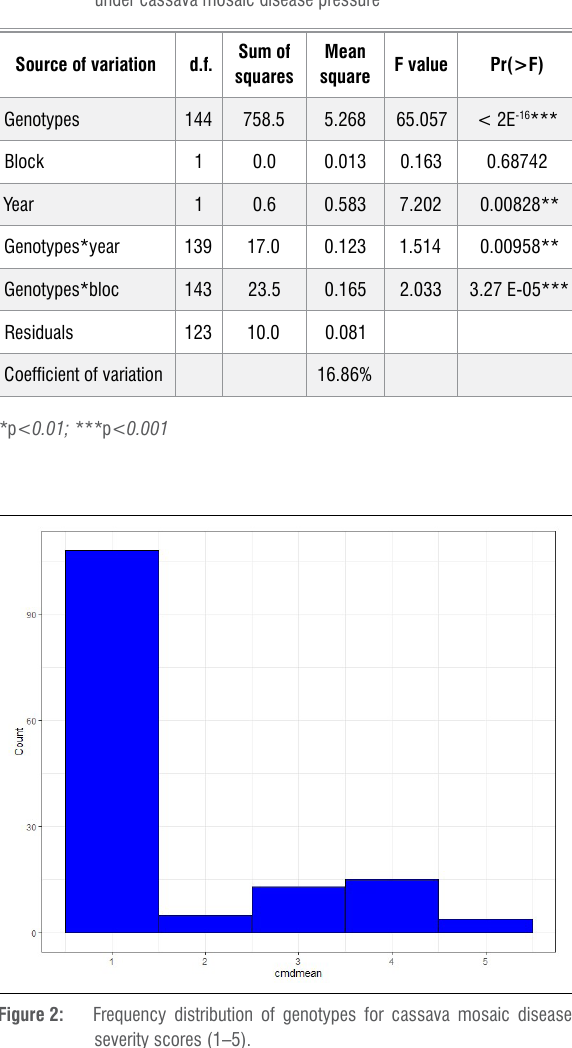
Analysis of variance of cassava genotypes and other components under cassava mosaic disease pressure